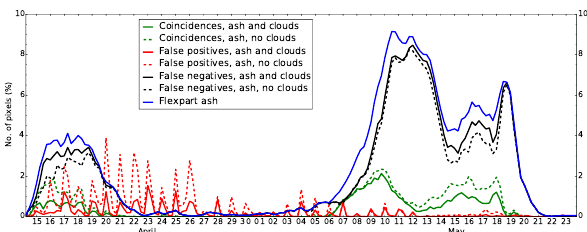
Figure 8. Ash detection time series for the Eyjafjallajökull (2010) eruption: the percentage of simulated pixels identified as ash (green lines). Dashed lines are for cloudless and solid lines for cloudy sim- ulations. (red lines) The percentage of false positive ash pixels with respect to the total number of pixels in the image. (black lines) The percentage of false negative ash pixels with respect to the total num- ber of pixels in the image. (blue line) The percentage of pixels with Flexpart ash-mass loading above 0.2gm − 2 .